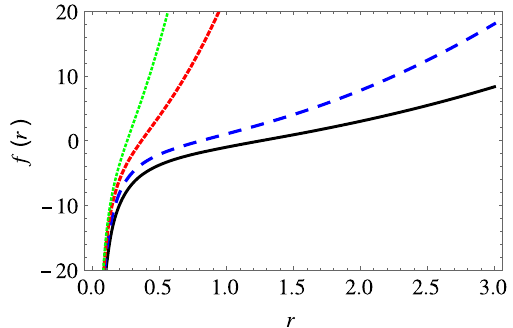
Fig. 1 Lapse function for (cid:13) = 0 . 00 (black solid line), (cid:13) = 0 . 75 (dashed blue line), (cid:13) = 1 . 50 (short dashed red line) and (cid:13) = 2 . 00 (dotted green line). The other values have been taken as unity. See text for